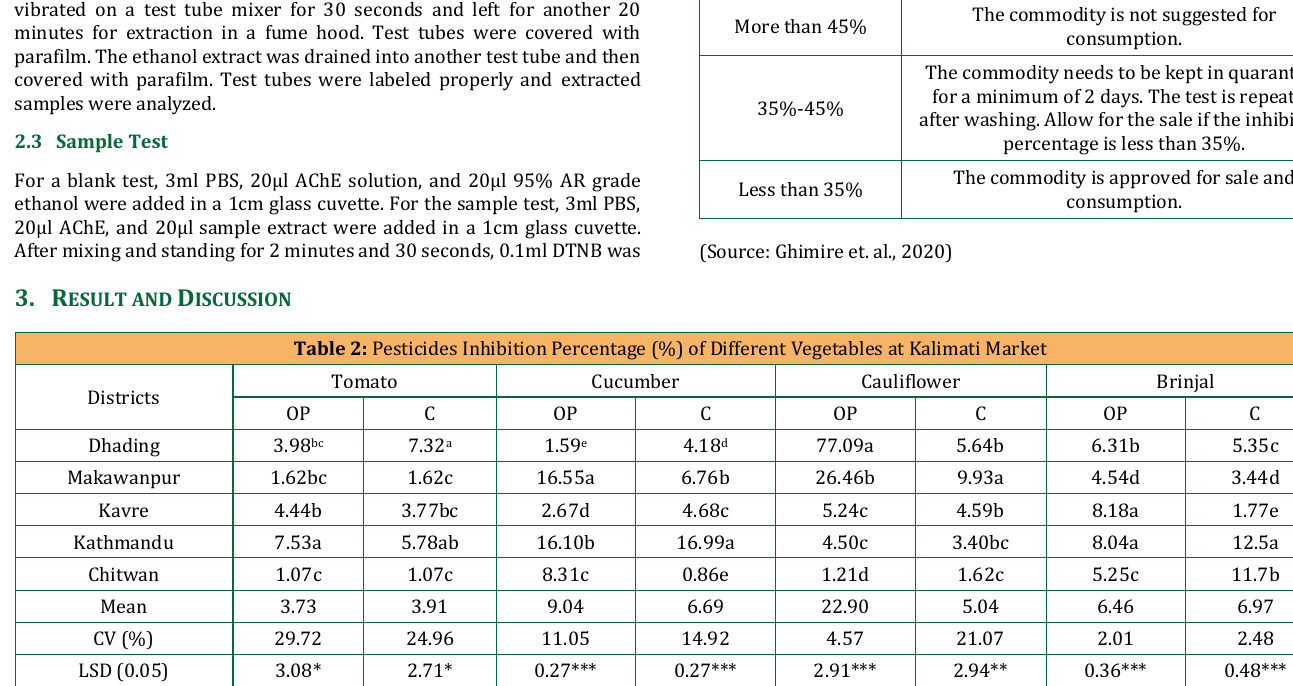
Table 1: Enzyme Inhibition Percentage and Result Interpretation Enzyme Inhibition Result Propose